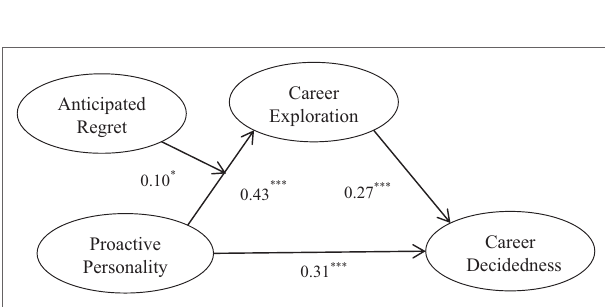
FIGURE 2 | Interactive effect of proactive personality and anticipated regret on career